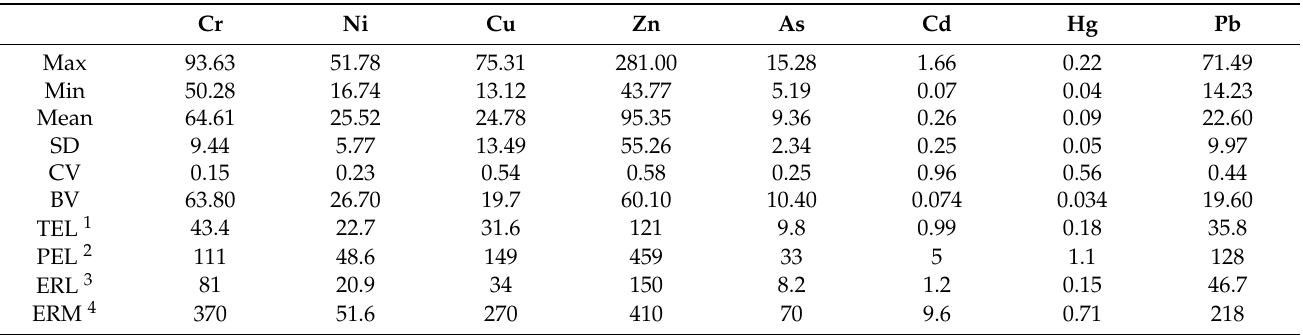
Table 4. Descriptive statistics for PTE concentrations (mg/kg) in river surface sediments samples of